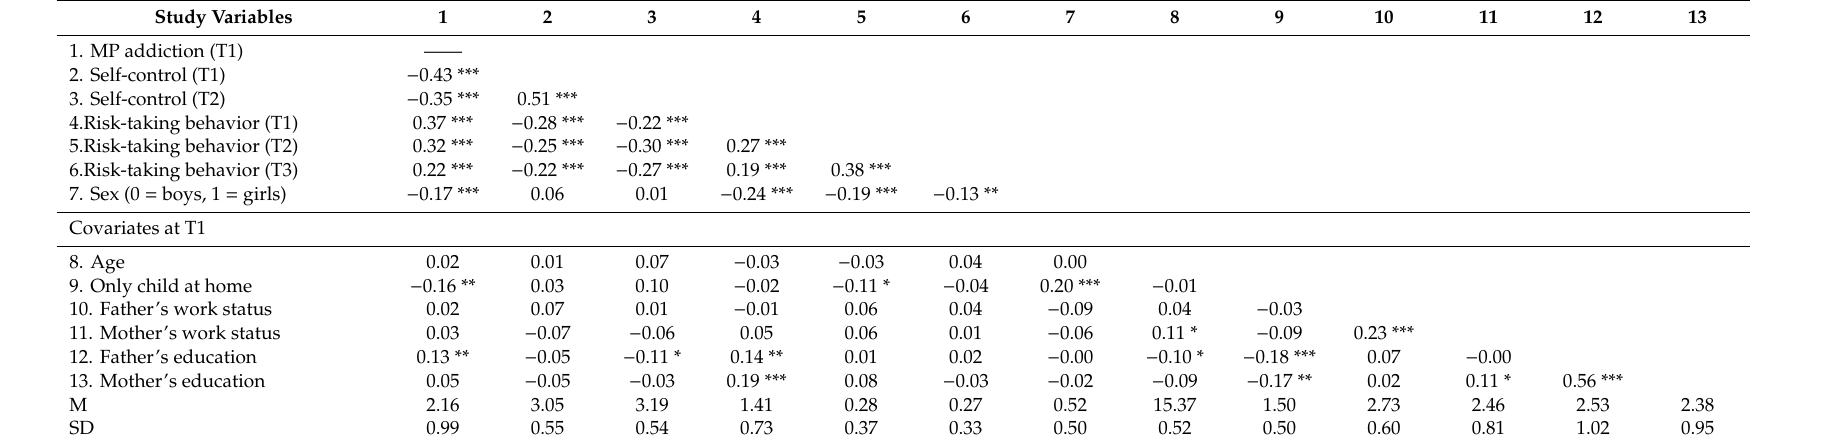
Table 2. Descriptive statistics and bivariate correlations among the study variables and